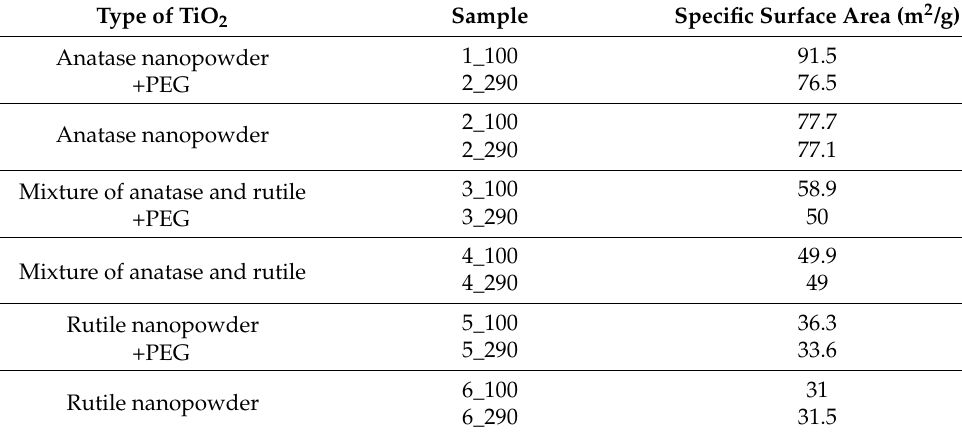
Figure 2. Scanning electron microscopy (SEM) images showing: ( a ) nanoparticles of titanium dioxide on coated type C roof tiles; ( b ) different spectrum areas in which elemental analysis was made. Table 1. Samples and results of their specific surface area.